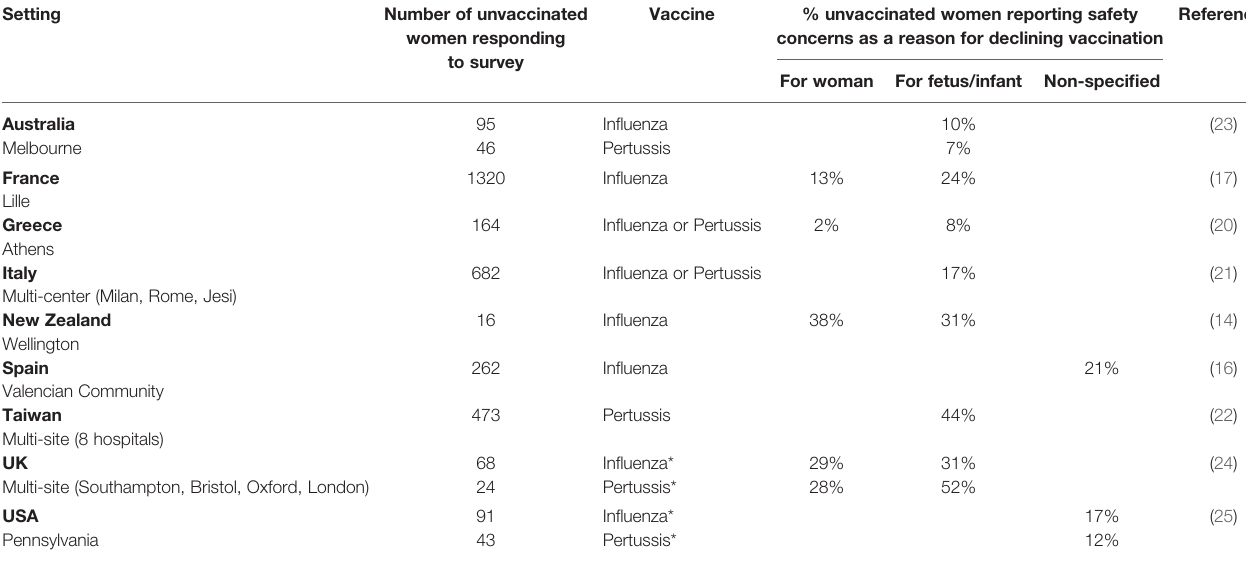
TABLE 2 | Prevalence of safety concerns as a reason given by women for not taking up in fl uenza and/or pertussis vaccination in pregnancy.